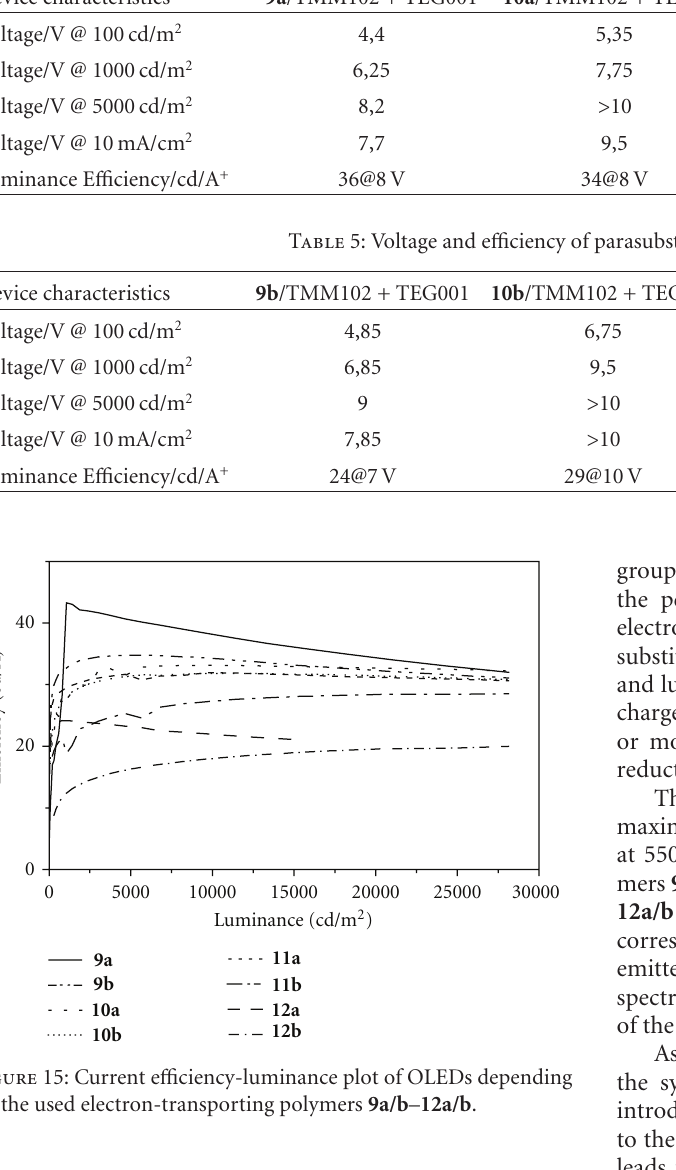
Table 4: Voltage and e ffi ciency of metasubstituted polymers 9a–12a . Device characteristics